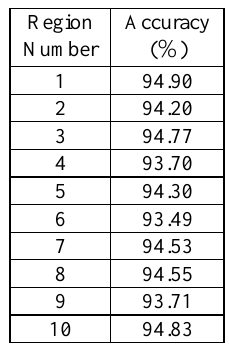
Tab. 7 statistical table of the accuracy of review results in some test